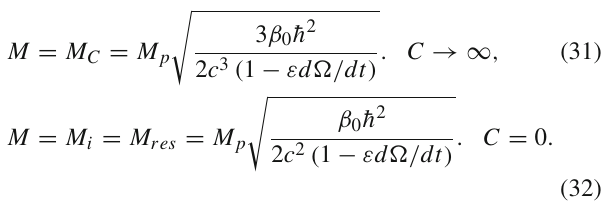
temperature and heat capacity correspond to revised Hawk- ing temperature and modified heat capacity based on